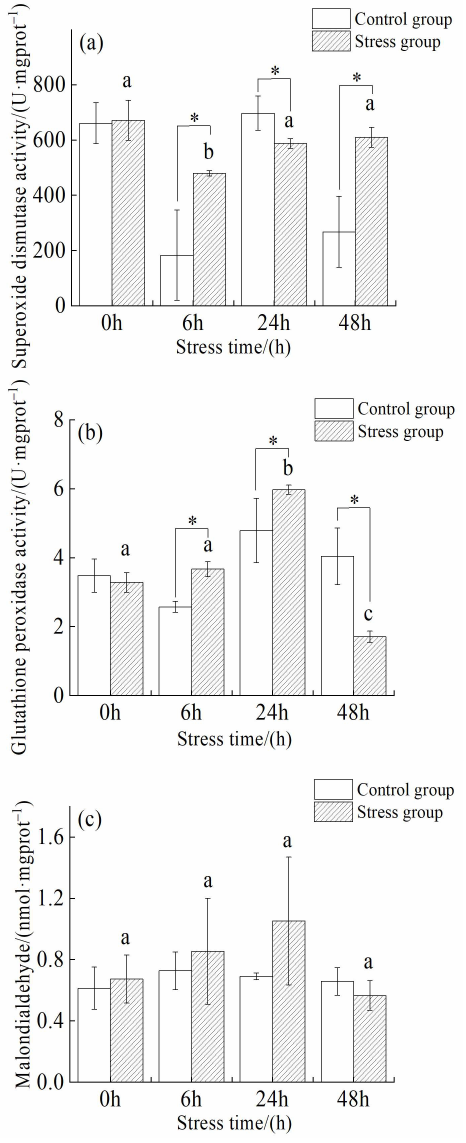
Figure 5. Effect of acute low salt stress on the antioxidation of white muscle of juvenile yellowfin fish ( Thunnus albacares ), ( n = 9). ( a ), Superoxide dismutase activity; ( b ), Glutathione peroxidase activity; ( c ), Malondialdehyde. Different letters indicate the difference between the experimental group and the control group over time, and * indicates the difference between the experimental group and the control group.